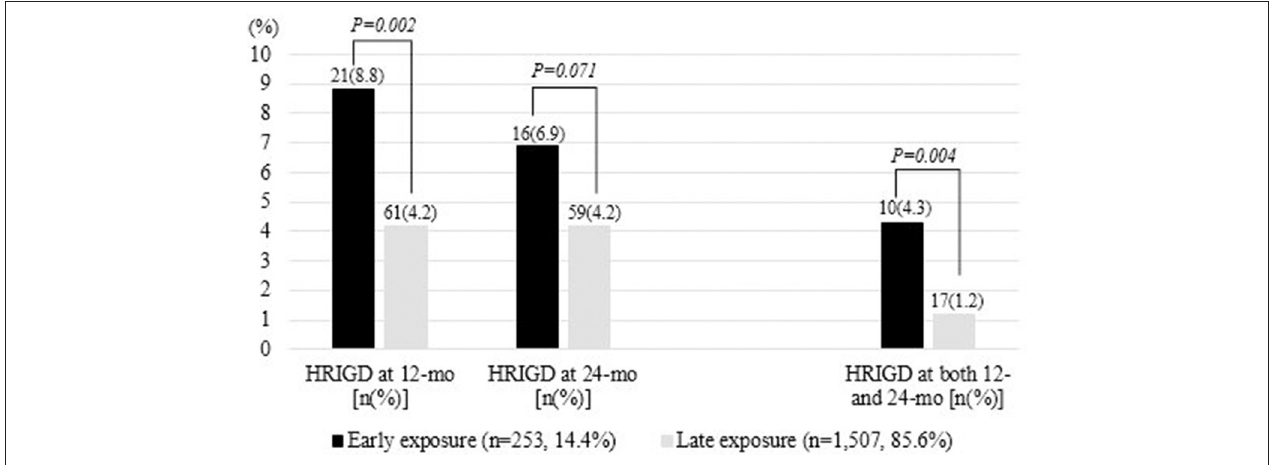
FIGURE 2 | Incidence of HRIGD in the early- and later-exposure groups at 12 and 24 months of follow-up. HRIGD, high risk of internet gaming disorder.